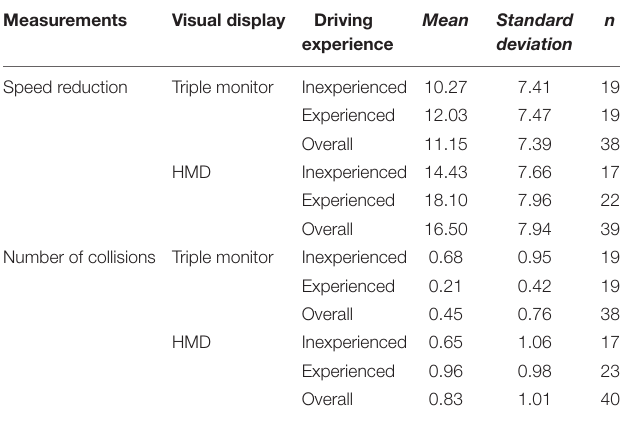
TABLE 4 | Descriptive data for the reduction of driving speed and the number of collisions for the two display devices and driver groups. Measurements Visual